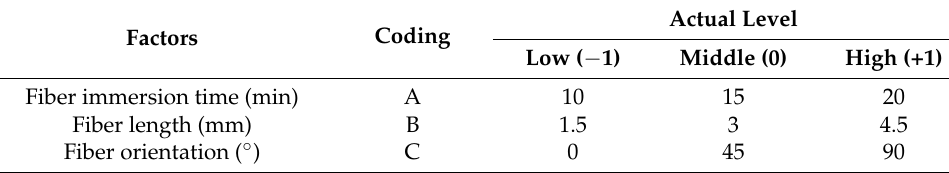
Table 2. Selected Factors and Levels.